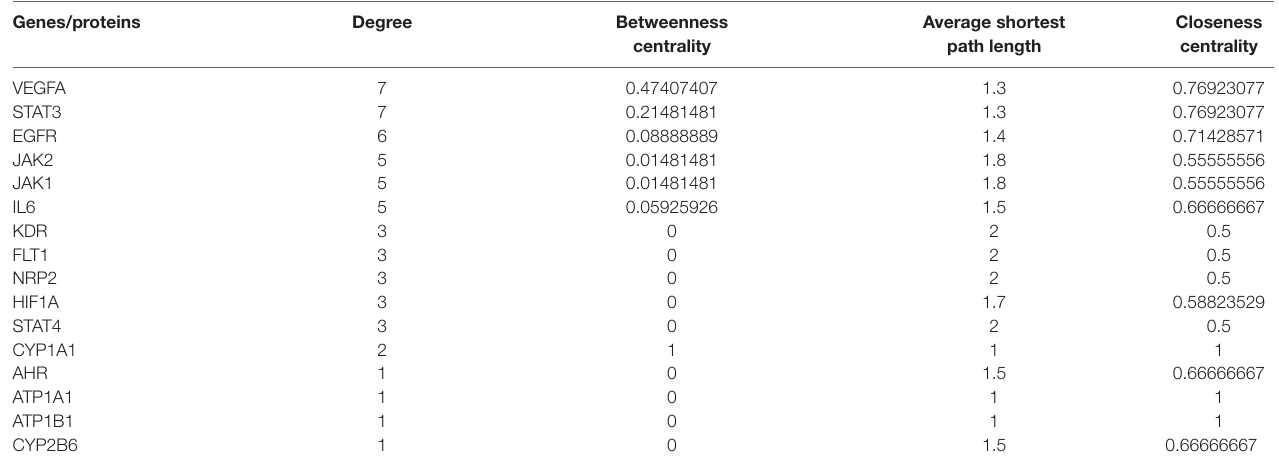
TABLE 5 | The topological parameters of PPI network.